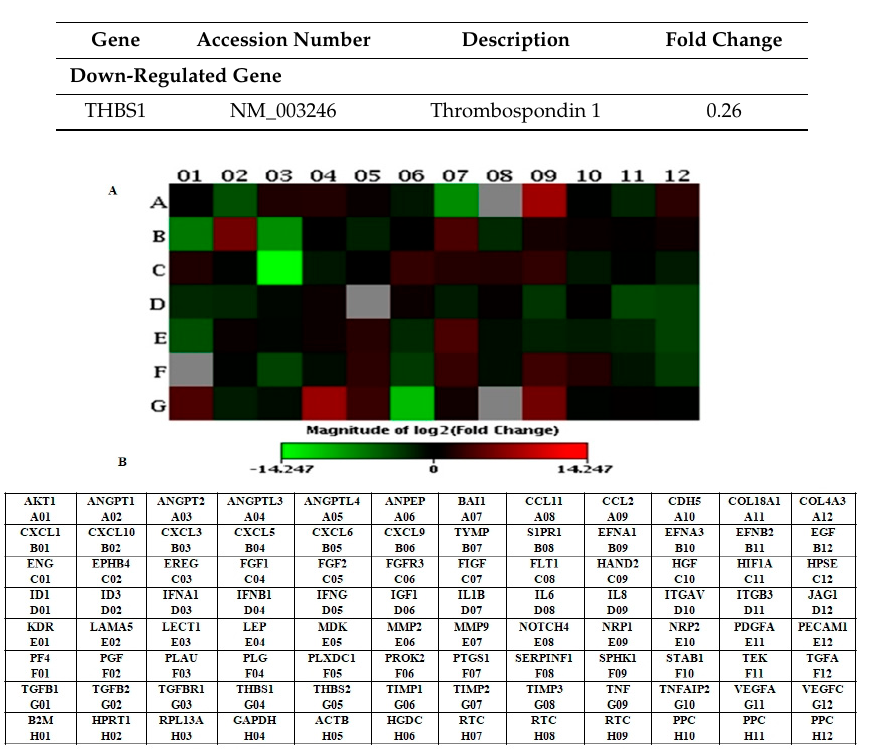
Figure 1. ( A ) Heat map showing differentially expressed genes in LNCaP-MST cells. The blocks represent high and low-level expressions respectively. The genes such as THBS1 and MMP9 (G-04 and E-07) were significantly up-regulated in LNCaP-MST cells. ( B ) Human angiogenesis gene table (PAHS-024) used in RT 2 profiler PCR array experiments.